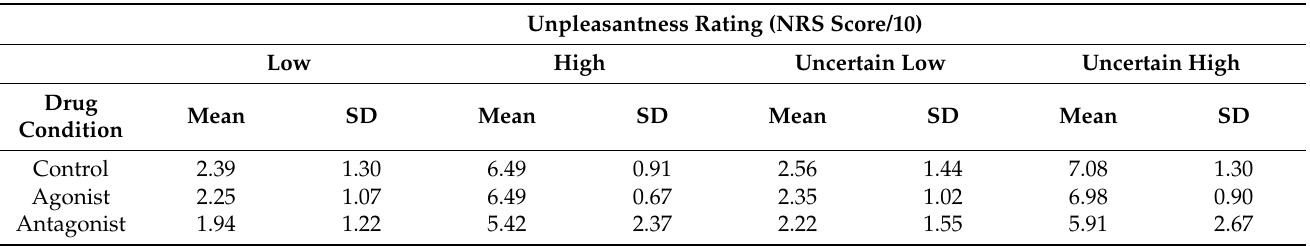
Table 2. Unpleasantness rating descriptive statistics. The ratings are separated into cue type and drug condition. Ratings are reported as mean and standard deviation.